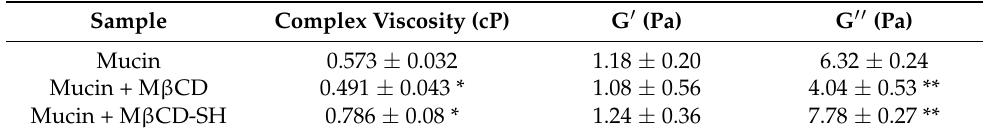
Table 2. Complex viscosity ( η *), elastic modulus (G (cid:48) ), viscous modulus (G (cid:48)(cid:48) ) of M β CD and M β CD-SH, with respect to the plain mucin dispersion. (* p < 0.05; ** p < 0.01 in respect of sample “Mucin”). Three independent experiments were performed and data are reported as average value ± standard